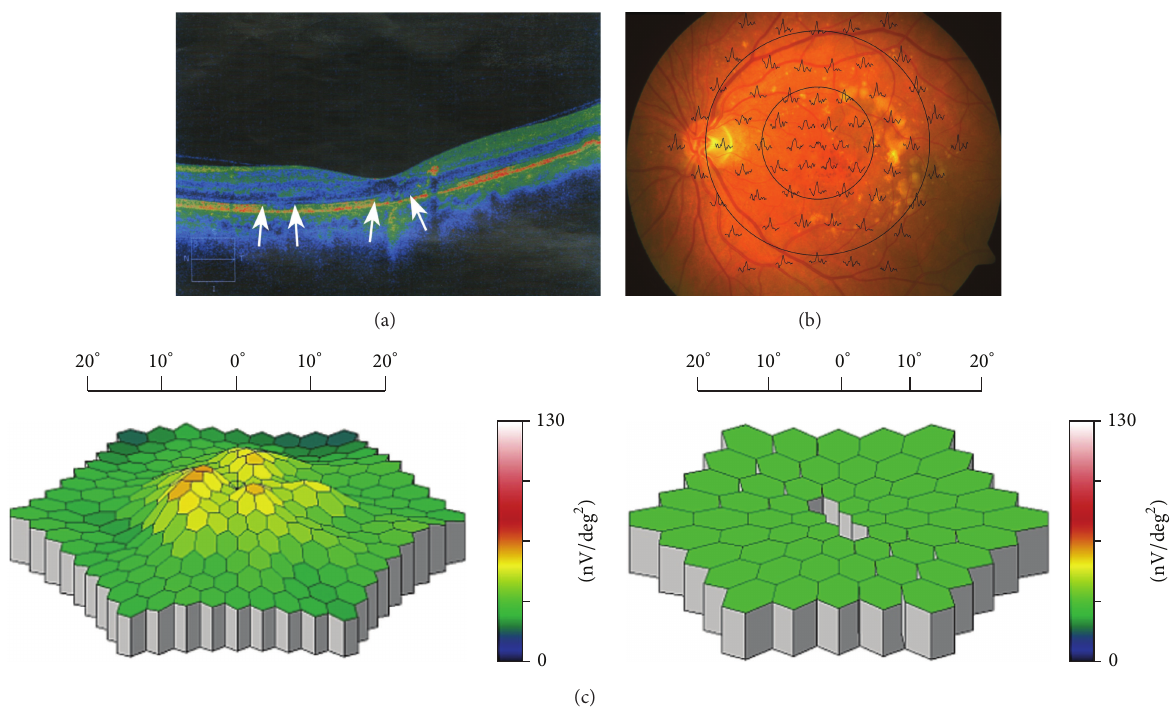
Figure 3: (a) SD-OCT of the same left eye shown in Figure 2(a), taken 2.5 years after rheohemapheresis treatment. Dry form of AMD. In addition to the perfect attachment of the original DPED, there is evident attachment and restoration of the previously detached and degeneratively damaged photoreceptor IS/OS junction, with the exception of two small defects in the central fovea and to the left of it (these defects are located between both the left and right pair of arrows). To the right of the central defect, there is also a small portion of the IS/OS junction which is not visible because it becomes a part of the vertically oriented optical shadow under a dense particle. The remainder of the original junction degeneration is offset towards the inner part of the retina into its plexiform layer. The abovementioned vertical optical shadow does not preclude the presence of the junction section already attached to its intact neighboring sections. Clear morphologic rectificationofthepositionandstructureofthephotoreceptorIS/OSjunctioncorrespondstotherestorationofvisualacuityofthiseye(BCVA 20/25 (0.8) and improvement of mfERG). (b) Multifocal electroretinogram—responses after RHF. Superposition of mfERG responses to the fundus of the left eye of the patient from (a). (c) A three-dimensional image of the electrical activity of the retina after RHF. Left: A three- dimensional image of the electrical activity of the retina of the left eye of the patient from (a) with increased parafoveal activity, compared to the normal-for-age image on the right (increase of parafoveal activity moves back into the normal range, illustrated by the change from grey depressions to green columns in the parafoveal